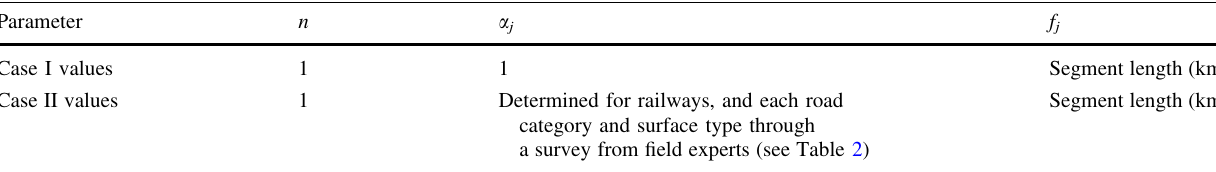
Table 1 Cost function parameters used for Case I and Case II analyses Parameter n